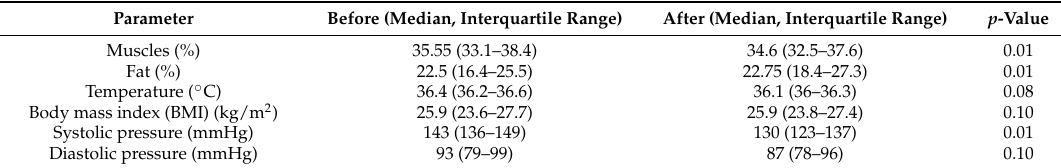
Table 1. Anthropometric characteristics of the cohort; results of the Wilcoxon matched pairs test. Parameter Before (Median, Interquartile Range) After (Median, Interquartile Range) p -Value